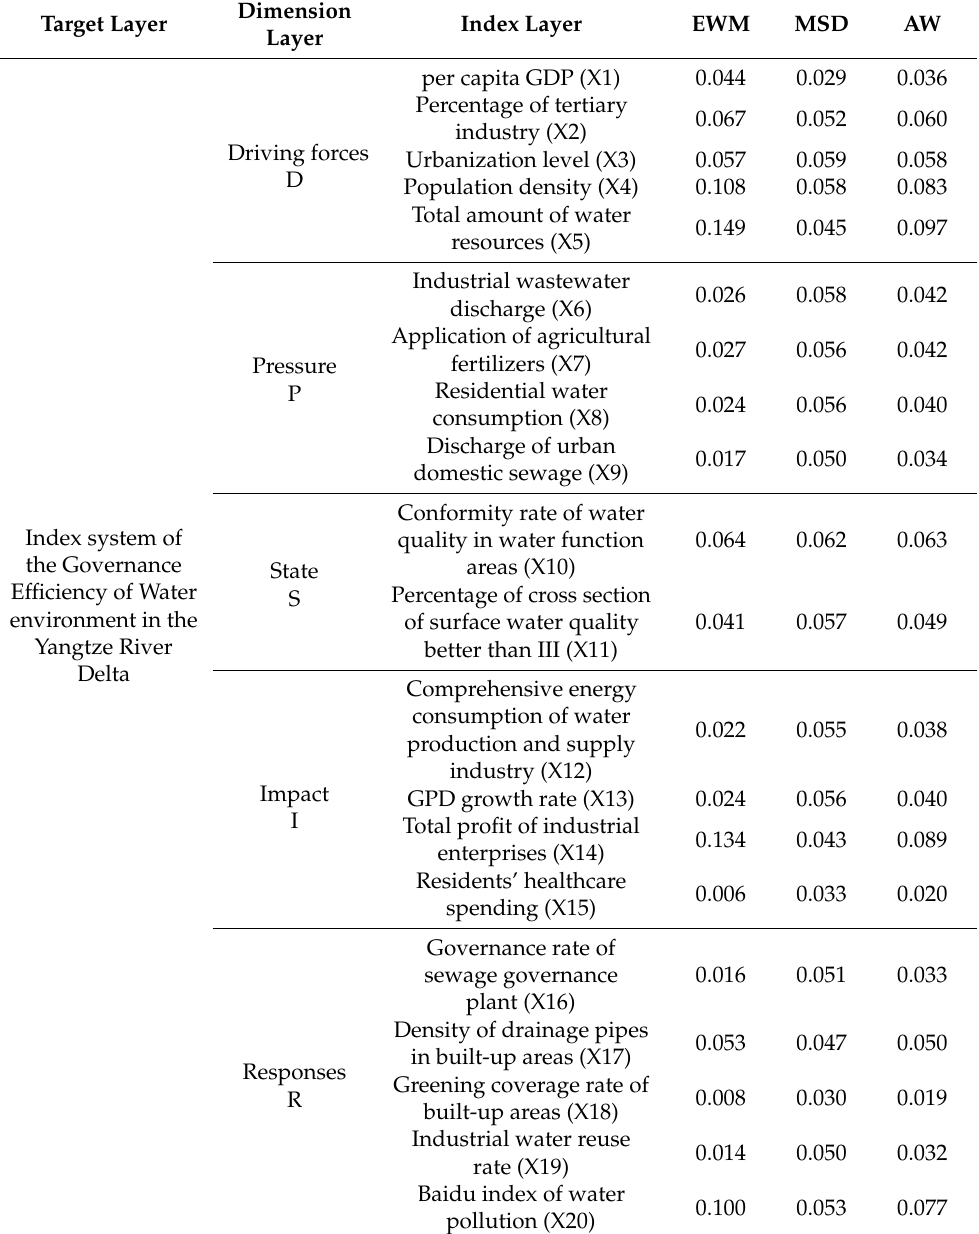
Table 2. Calculation results of EWM method and MSD